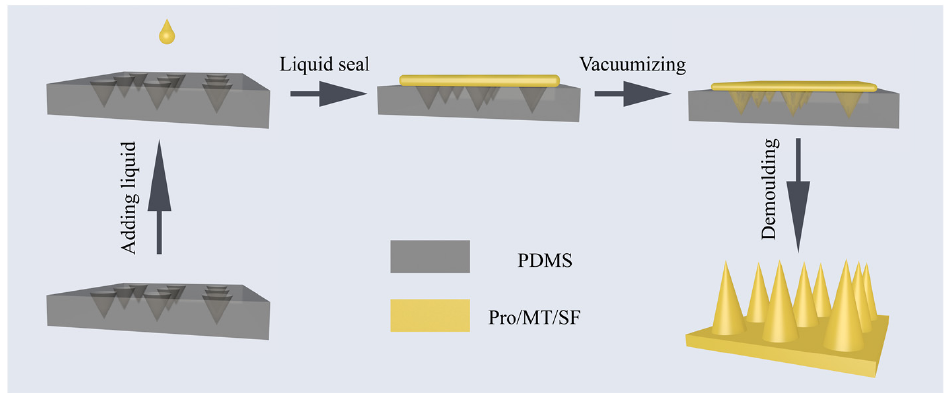
Figure 1. The preparation process of melatonin-loaded silk fibroin microneedle (MT/SF@MNs): the mixture was poured into a polydimethylsiloxane microneedle mold, evacuated 3 times to remove the bubbles, and then dried in a constant temperature and humidity room for 8 h (25 ◦ C, 55%RH) and demolded to obtain